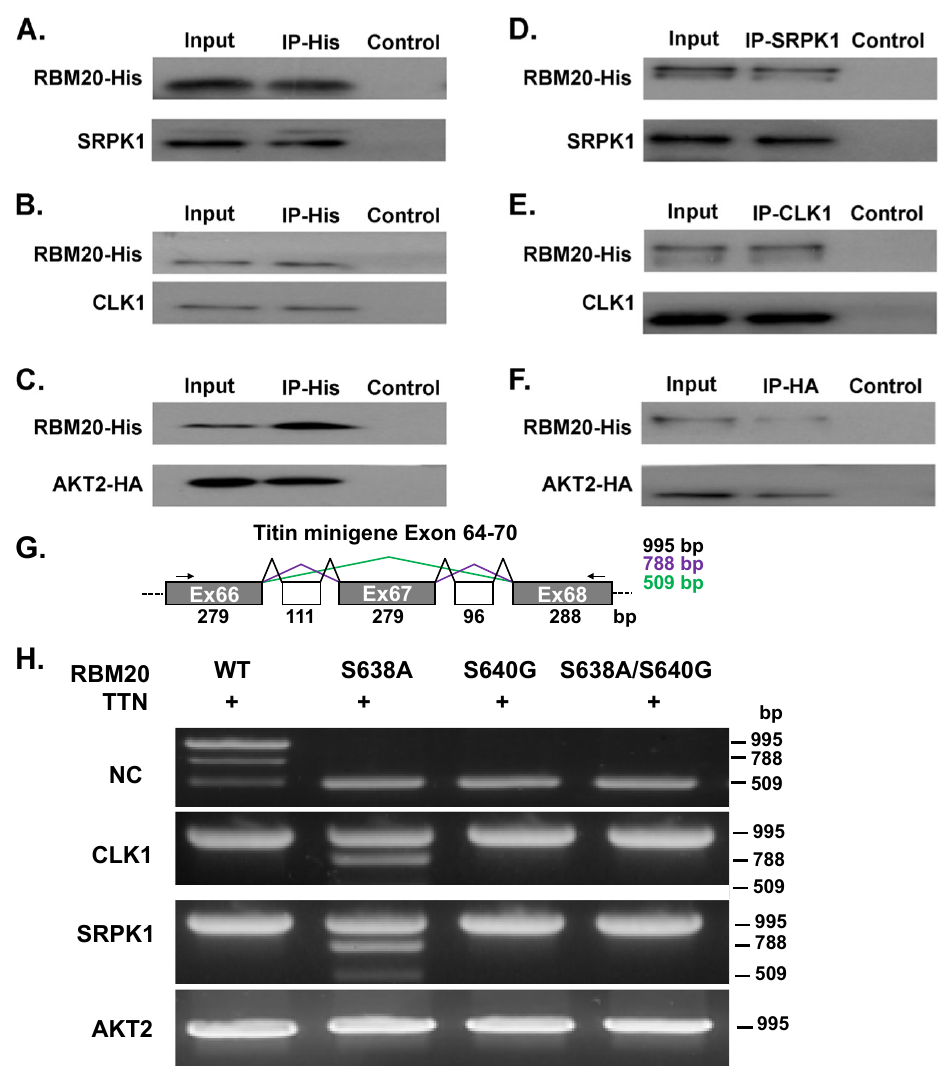
Figure 3. SR protein kinases interact with RBM20 and regulate Ttn pre-mRNA splicing in HeLa cells. ( A – C ) Pulldown of kinases with His-tagged RBM20 was assessed by using Western blot. ( D – F ) Pulldown of His-tagged RBM20 by SRPK1, CLK1, or HA-tagged AKT was evaluated by Western blot. ( G ). Schematic showing Ttn minigene splice variants with sizes indicated. ( H ). RT-PCR detection of Ttn minigene splice variants after co-transfection with individual SR protein kinases and either WT or mutant RBM20. Input, total protein before co-IP; IP–His, elution from co-IP with anti-His-tag antibody; Control, elution from co-IP without antibody conjugation to the beads; NC, control without kinase transfection; WT, RBM20 wild type.